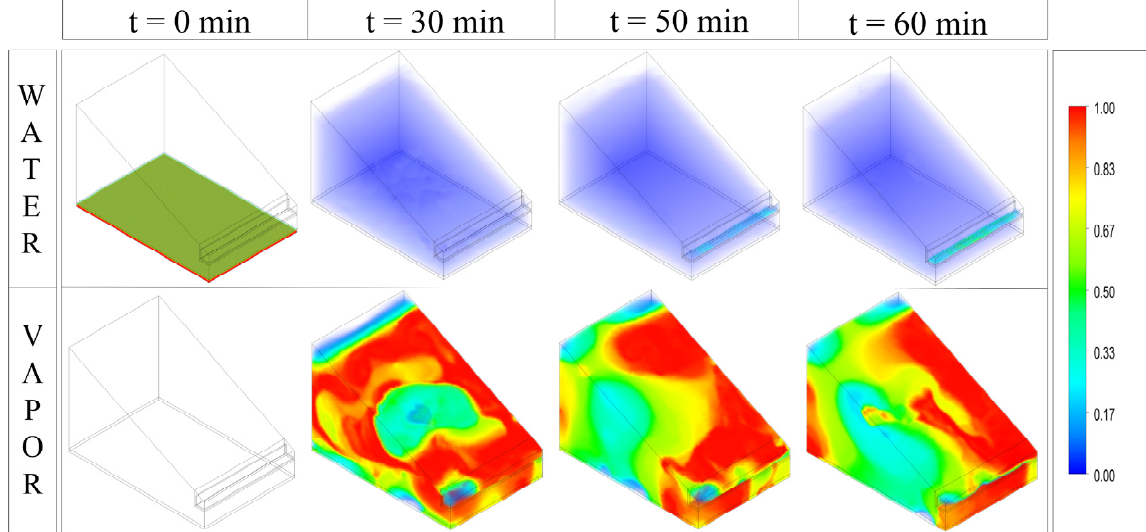
Figure 11. A volumetric fraction over time with volume rendering of water and vapor.